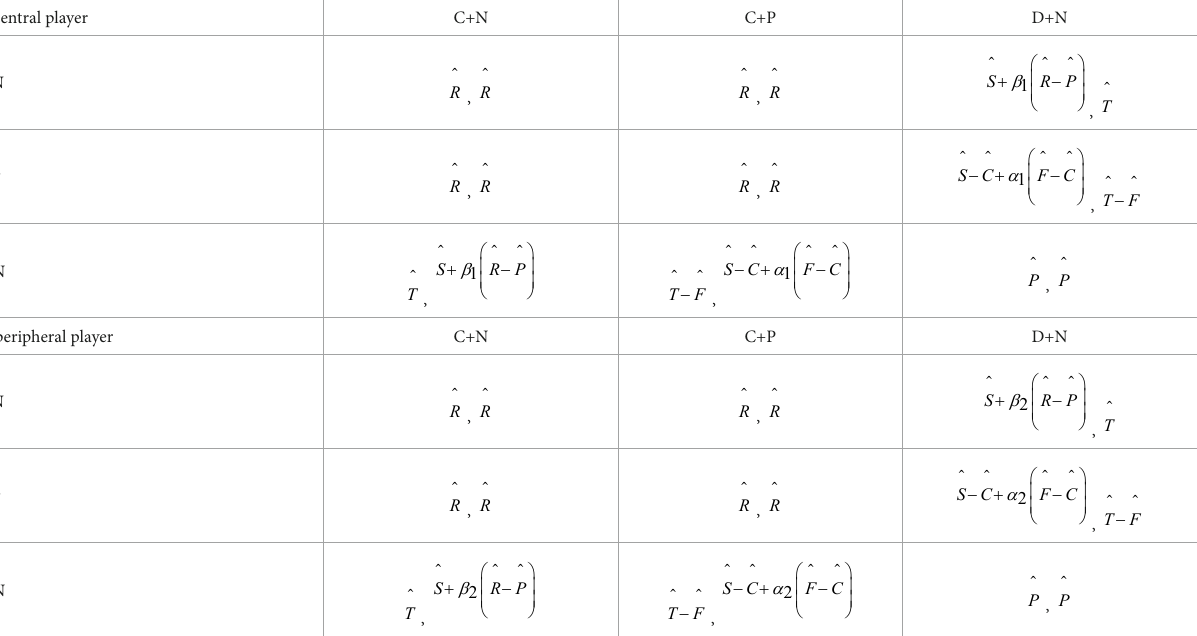
TABLE 6 Utility matrix in the two-stage prisoner’s dilemma game.